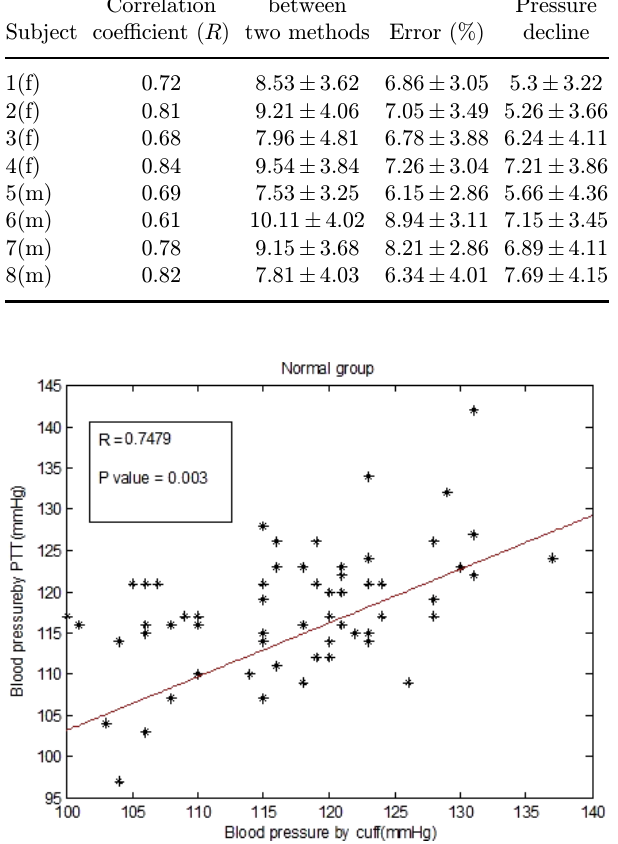
Fig. 5. Plot of systolic BP measured by cu® vs systolic blood pressure calculated from the pulse transit time of the normal group. The straight line represents linear regression (see inserted R and P value).